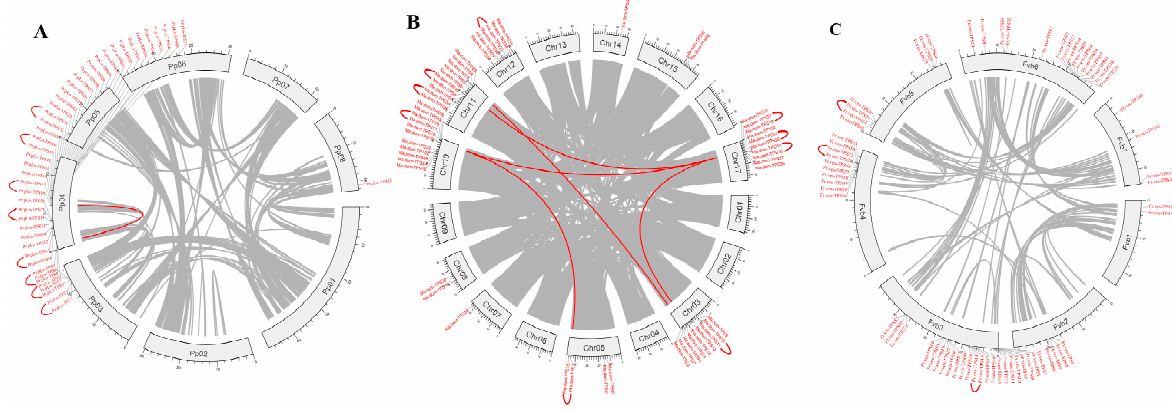
Figure 4. Inter-chromosomal relationships of TPSs in P. persica ( A ), M. domestica ( B ), and F. vesca ( C ). Grey lines in the circle indicate the collinear blocks in the P. persica or M. domestica genome. The red lines in the circle highlight the segmental duplicated TPS gene pairs, while the red curve outside the circle indicates the tandemly duplicated TPS gene pairs produced by MCSscanX.